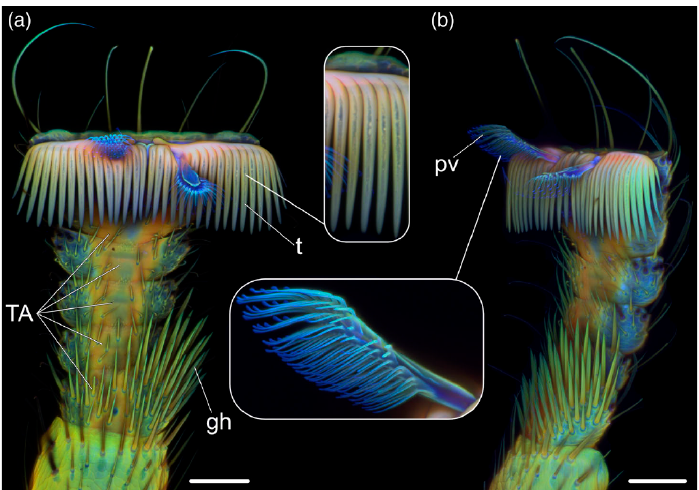
Figure 4. Images collected with a confocal laser scanning microscope from the leg at metathoracic position of B. coeca , under different AF measurement conditions favoring the bluish AF of resilin, or the yellowish or reddish AF of material at growing degrees of sclerotization. On these bases, the resilin-enriched pulvilli can be easily distinguished in the tarsomer (TA). ( a ) Ventral and ( b ) ventrolateral views; gh, grooming hairs; pv, pulvillus; t, claw tooth. Bar = 50 μ m. Modified from [47].